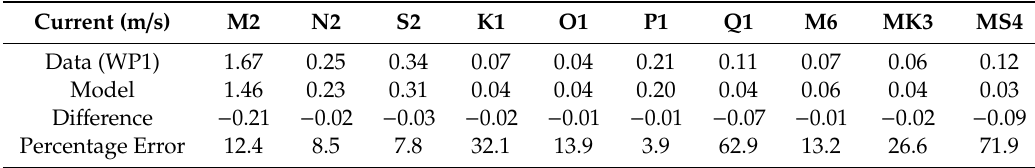
Table 5. Comparison of the observed and modeled tidal current constituents at WP1 in the Western